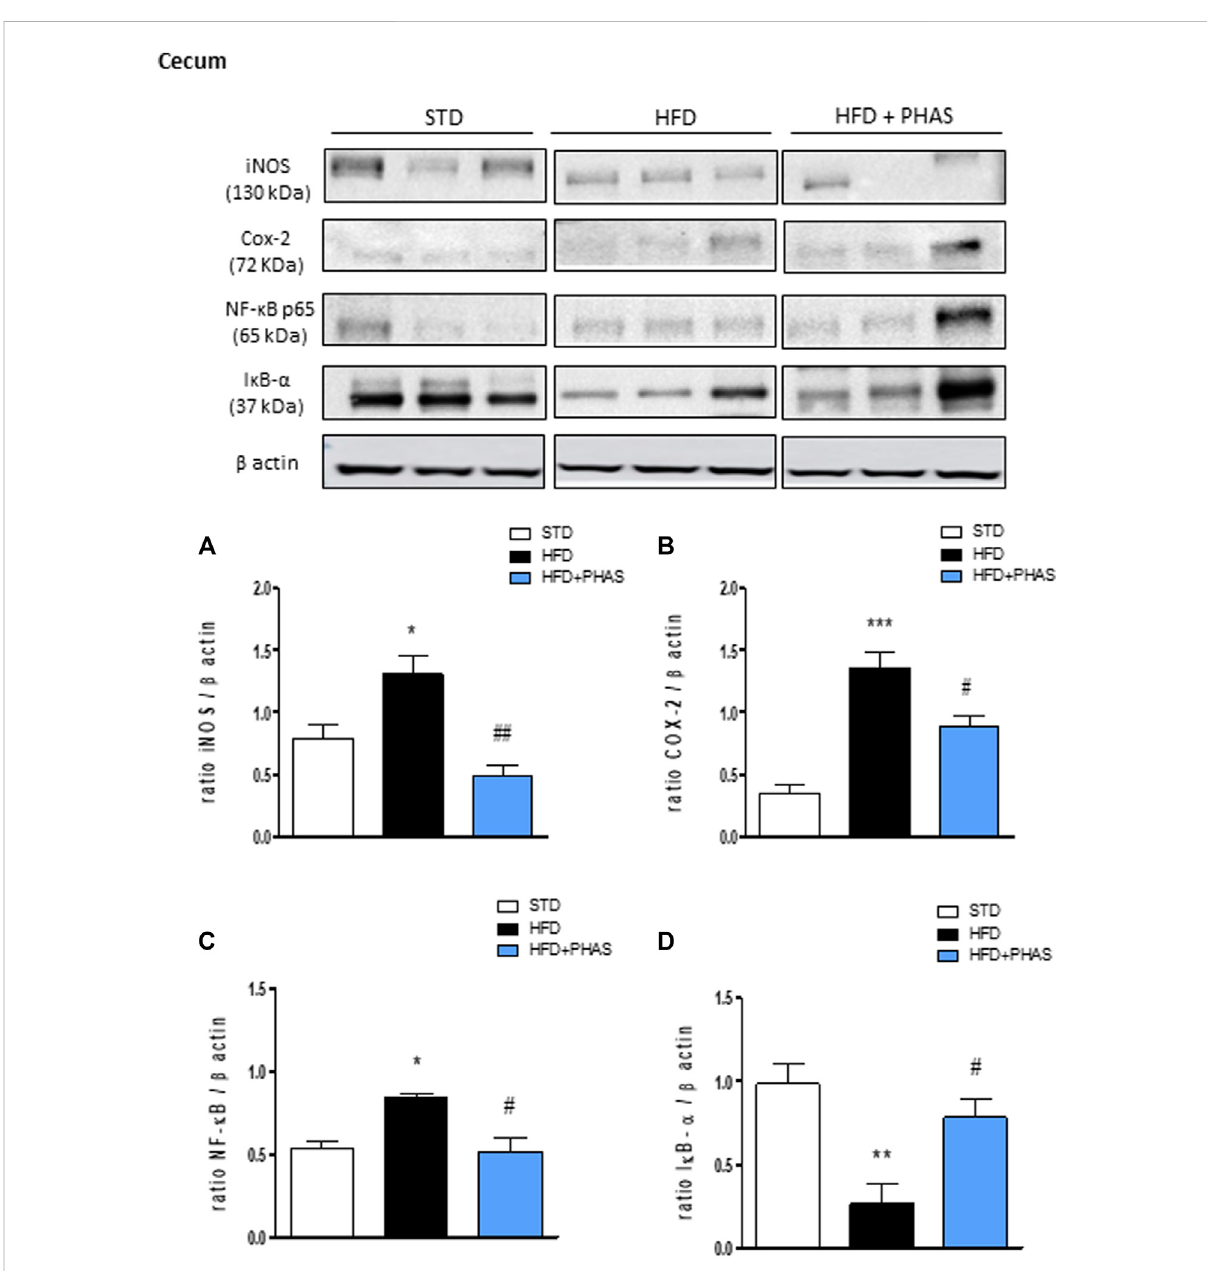
FIGURE 7 Effect of P. vulgaris extract (500 mg/kg, PHAS 500) treatment on (A) iNOS, (B) COX-2, (C) NF- κ B, and (D) I κ B- α in the cecum in HFD mice. Densitometric analysis of protein bands is reported: the levels are expressed as the density ratio of target to β -actin. Data are expressed as means ± SEM ( n = 6). * p < 0.05 and ** p < 0.01, and *** p < 0.001 vs. STD; # p < 0.05 and ## p < 0.01 vs.